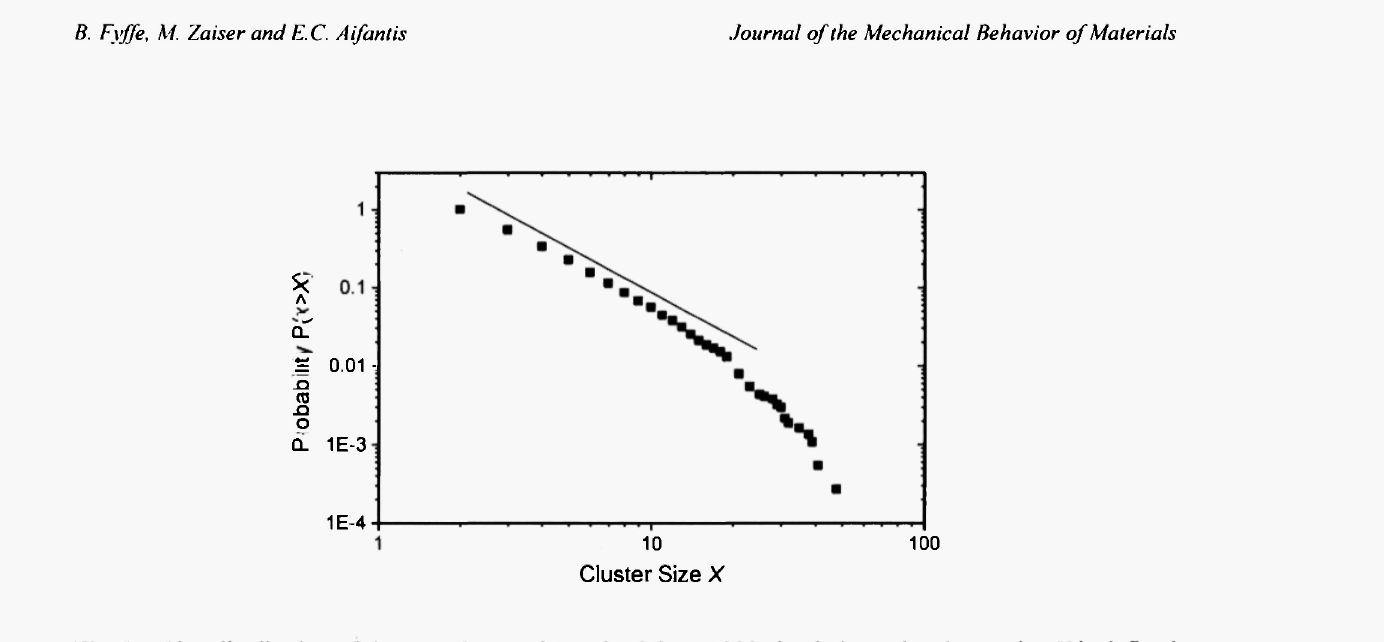
Size distribution of damage clusters determined from 1000 simulations; the cluster size X is defined as the length of a connected region where D(x)= 0.